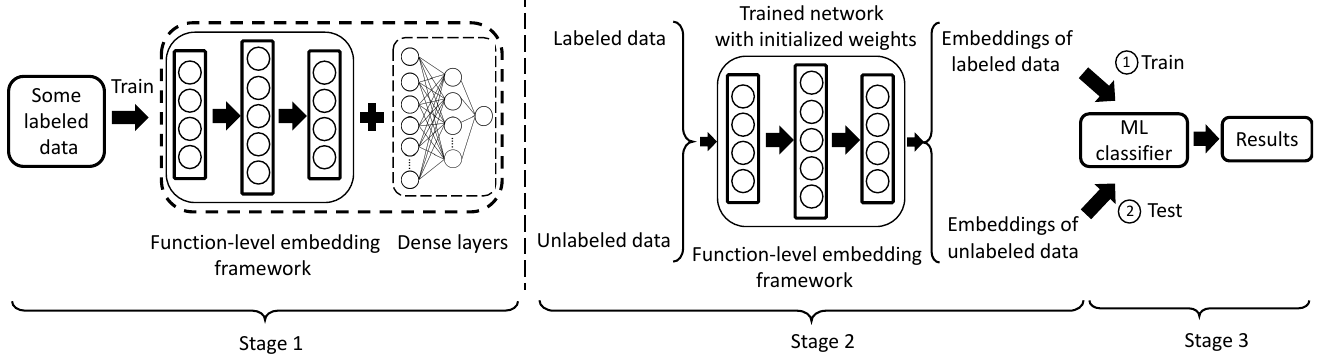
Figure 1. The proposed framework is designed for the scenario where there are some labeled data for a software project. This scenario consists of three stages: the first stage is to train the neural network with the labeled data; the second stage is to feed both the labeled and the unlabeled data to the trained network to obtain one of the hidden layers’ output as the learned function-level embeddings; and in stage three, the resulting embeddings can be used as feature sets for subsequent process, e.g., to train a conventional ML classifier for further